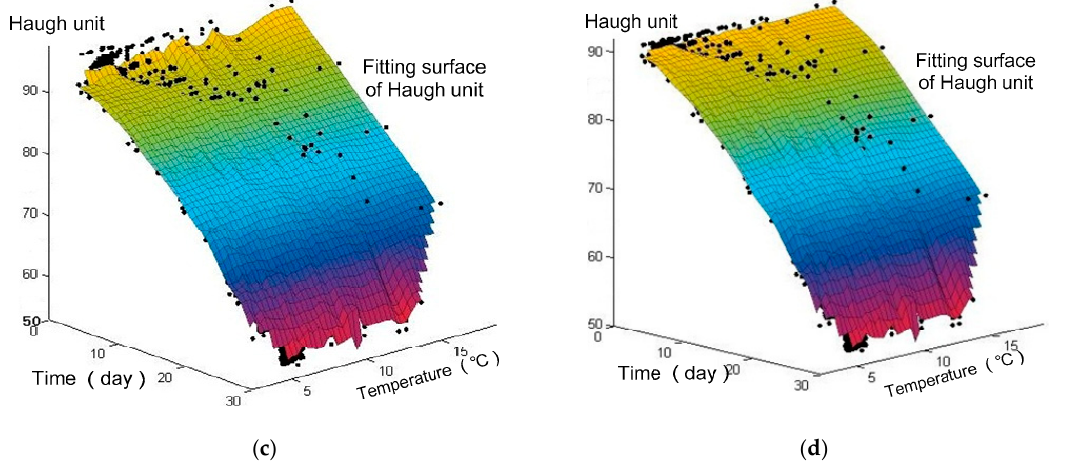
Figure 6. Haugh unit changes of Omega-3 polyunsaturated fatty acids ( n-3 PUFAs ) enriched and conventional eggs under different conditions. ( a ) Haugh unit changes of n-3 PUFAs enriched eggs under room temperature; ( b ) Haugh unit changes of conventional eggs under room temperature; ( c ) Haugh unit changes of n-3 PUFAs enriched eggs in refrigeration; ( d ) Haugh unit changes of conventional eggs in refrigeration.